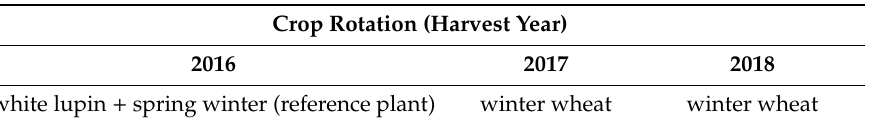
Table 2. Crop rotation in